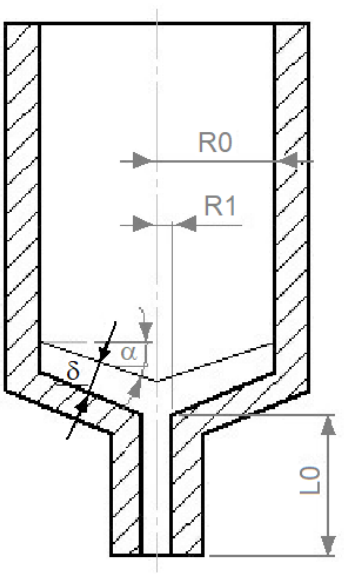
Figure 3. Main dimensions of the melting area of the printer [21].